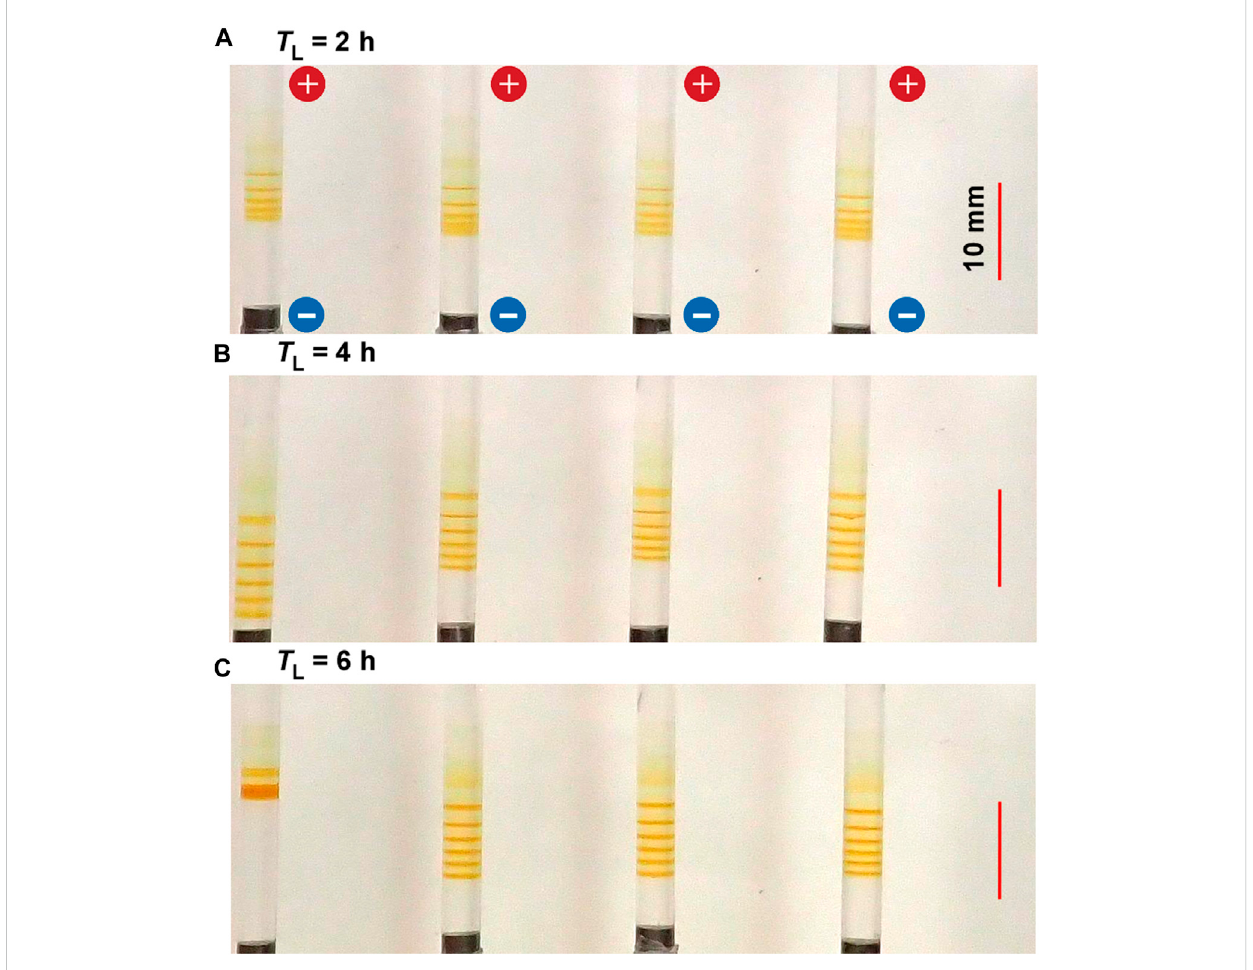
FIGURE 7 Typicalperiodicbandsformedinthefourgelcolumnswith L =50 mmat25 ° Cunderthe T L values (A) 2 (B) 4,and (C) 6 h.Here, E H =3 V, E L =1 V, T H = 1 h, and N C = 8 are kept constant. The scale bars are provided on the right parts of the images, and the charges of the electrodes are provided in the top